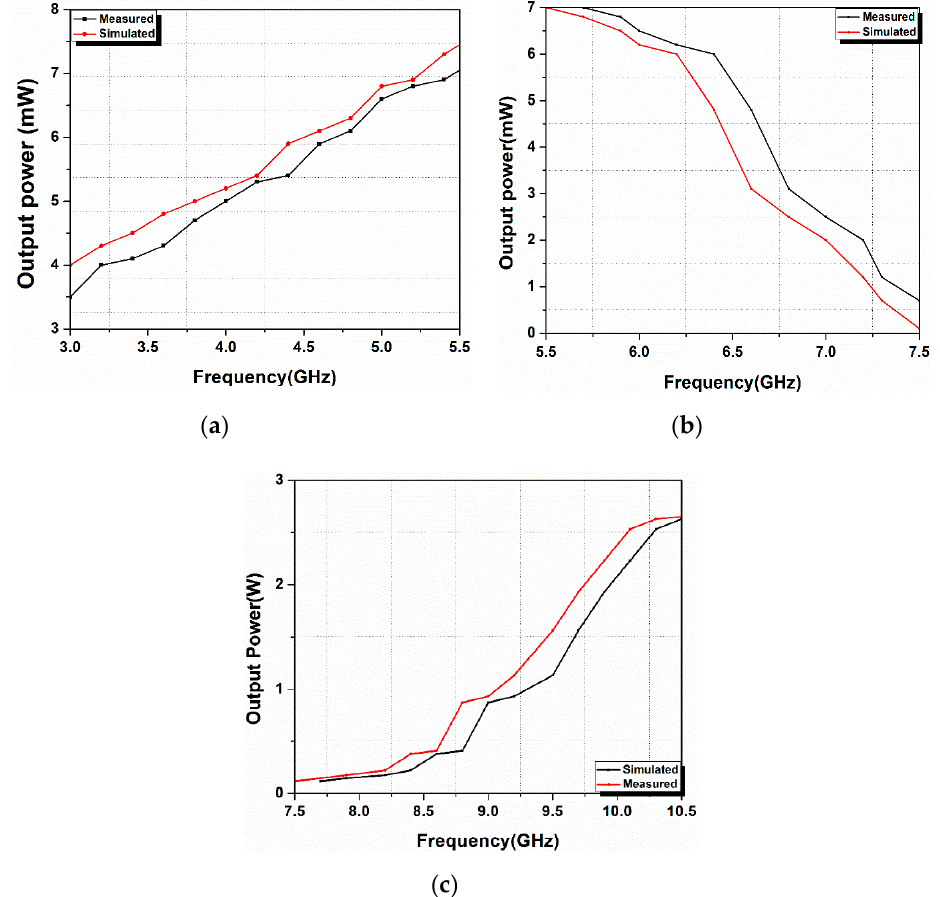
Figure 6. Plot of output power with respect to frequency ranging from ( a ) 3 GHz to 5.5 GHz, ( b ) 5.5 GHz to 7.5 GHz, and ( c ) 7.5 GHz to 10.5 GHz.